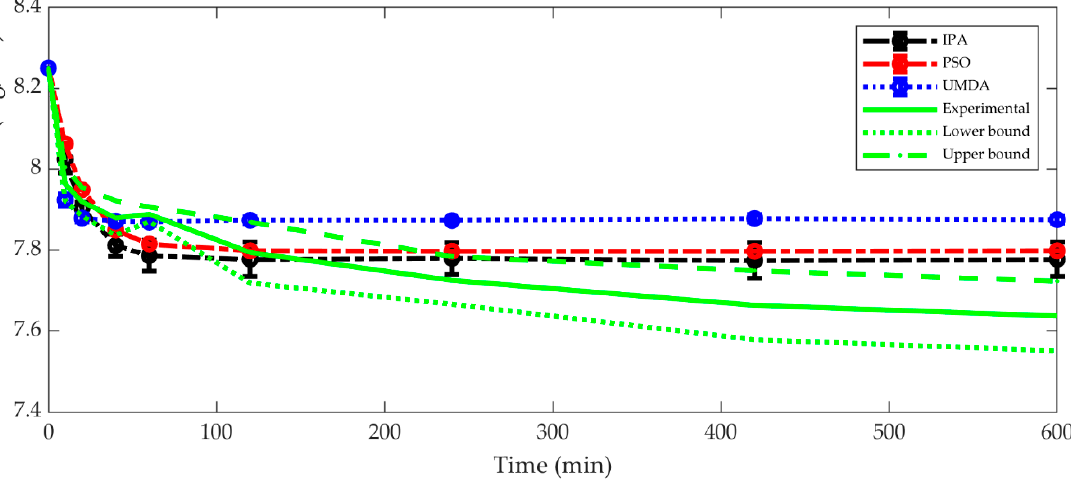
Figure 2. Best-fit to experimental data for Experiment No. 6 (pH = 5.7, T = 62 °C, enzyme–substrate ratio = 0.3343 𝜇 L enzyme/g cellulose). The kinetic parameter found by the four optimizers lead to the lowest calibration to experimental data.